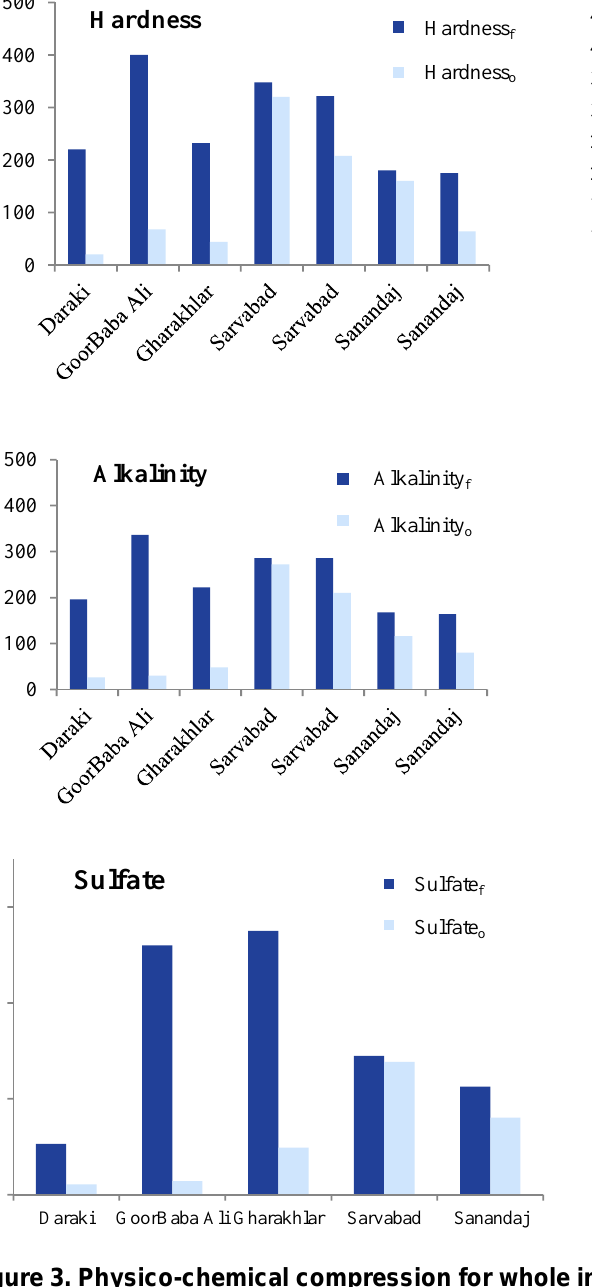
Figure 3. Physico-chemical compression for whole investigated species in feed and output water